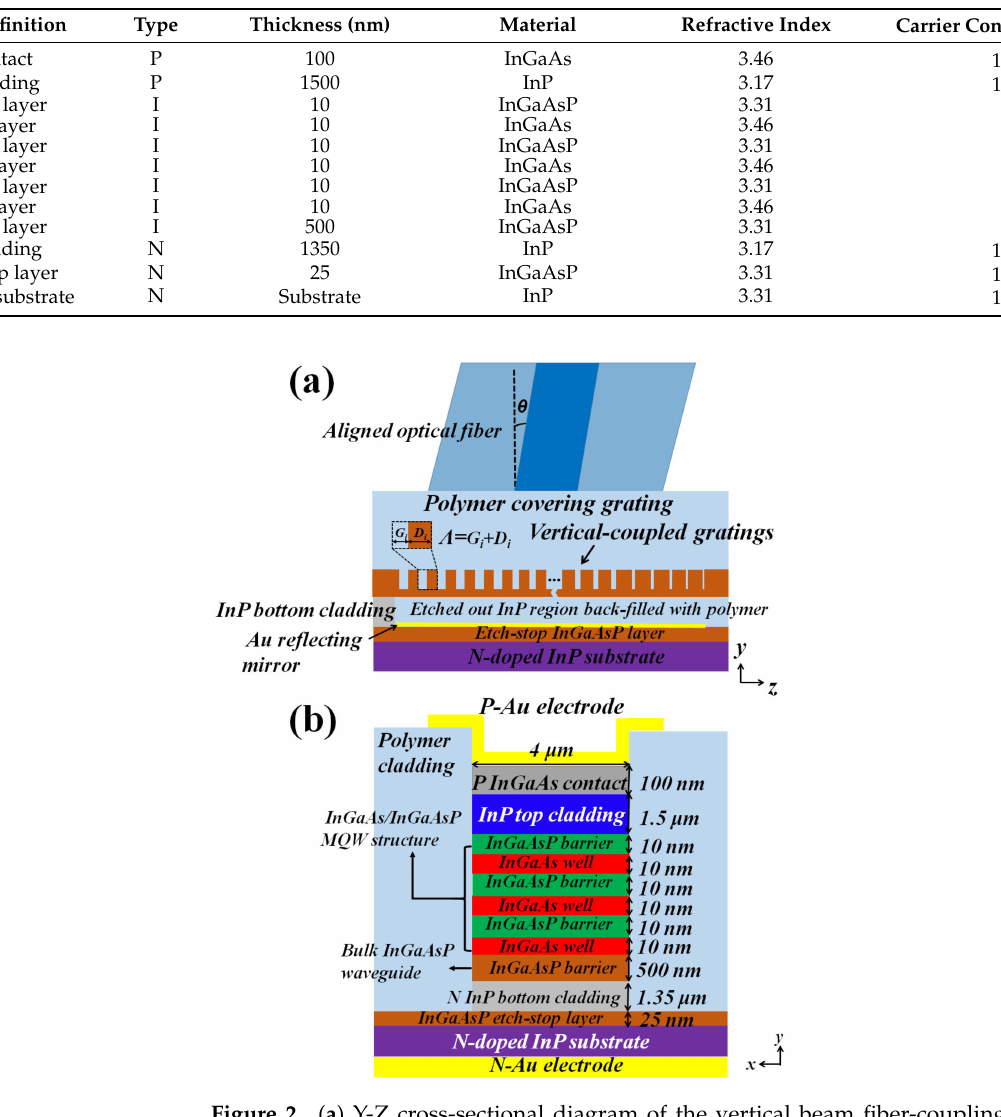
Figure 2. ( a ) Y-Z cross-sectional diagram of the vertical beam fiber-coupling apodized grating with a gold reflecting mirror structure below the grating. ( b ) Y-X cross-sectional diagram of the InGaAs/InGaAsP MQW active waveguide